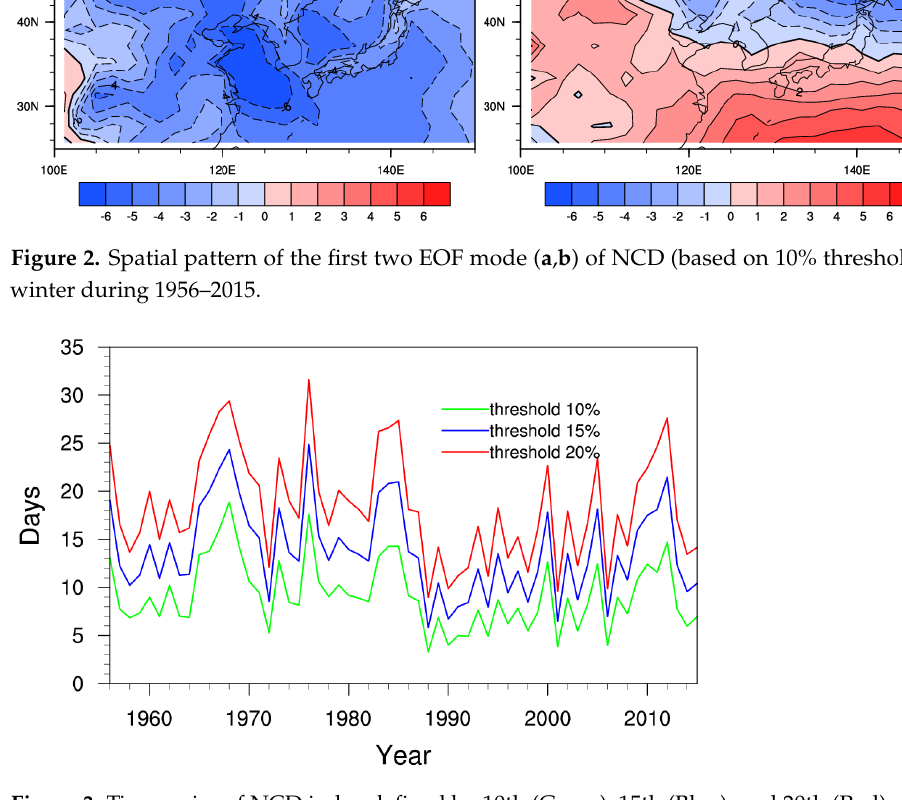
Figure 3. Time series of NCD index defined by 10th (Green), 15th (Blue), and 20th (Red) percentile during 1956–2015.